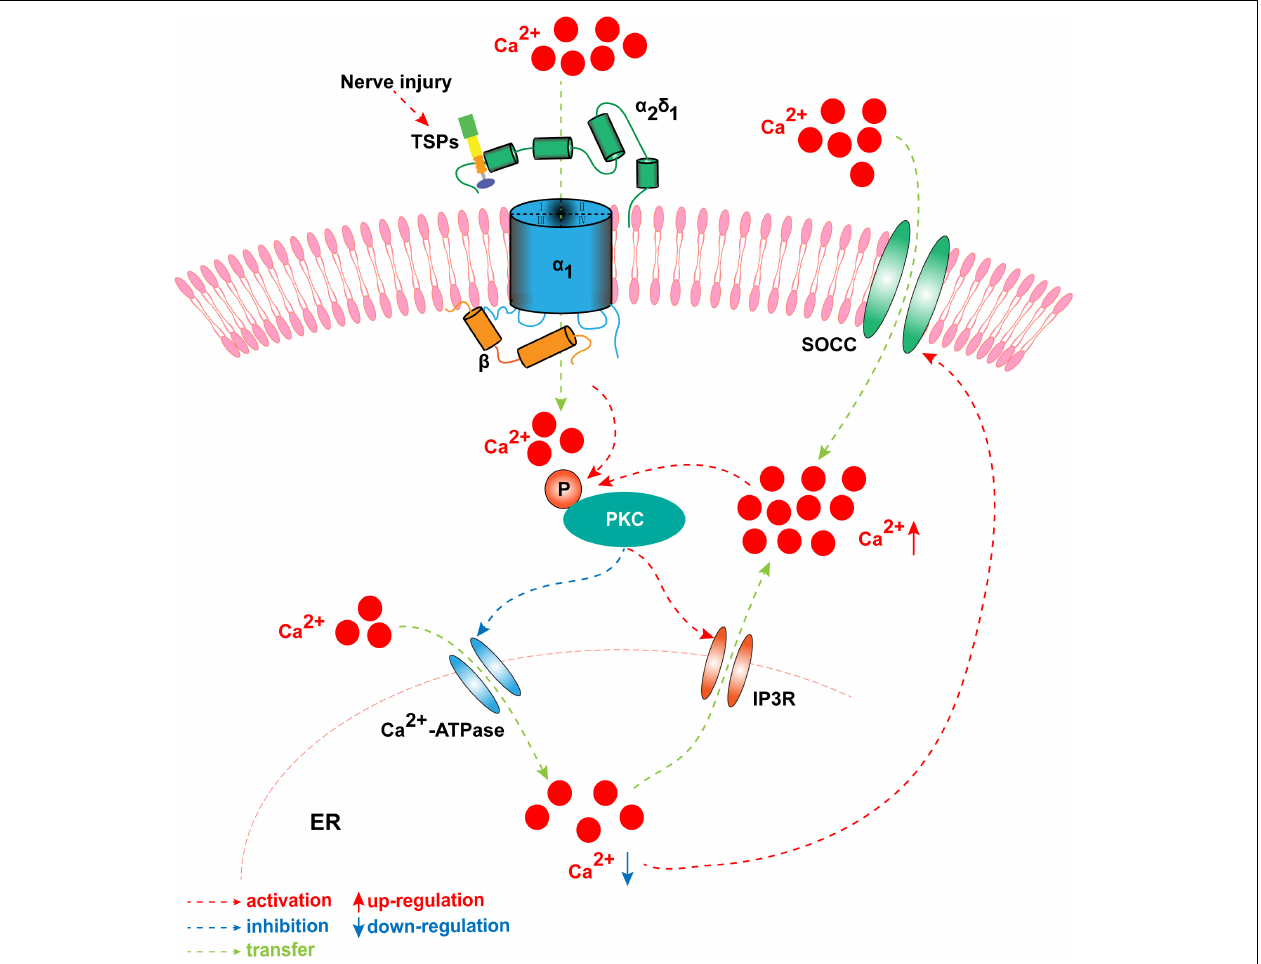
FIGURE 4 | The concentration of intracellular Ca 2 + is elevated by TSP4 via binding to Cav α 2 δ 1 and activating the downstream PKC signaling pathway when nerve is injured. Once nerve is damaged, TSP4 first binds with the Cav α 2 δ 1 and mediates Ca 2 + influx, and then induces the phosphorylation of PKC. The p-PKC decreases the function of endoplasmic reticulum (ER) Ca 2 + -ATPase and inhibits Ca 2 + entering into ER. Meanwhile, p-PKC activates IP3R and allows Ca 2 + flowing out of ER. It results in the downregulation of ER Ca 2 + concentration which induces the opening of store-operated calcium channel. These processes successfully cause the influx of Ca 2 + and the upregulation of intracytoplasmic Ca 2 + . Finally, the intracellular Ca 2 + further activates primary sensory neurons, which leads to the formation of peripheral sensitization.